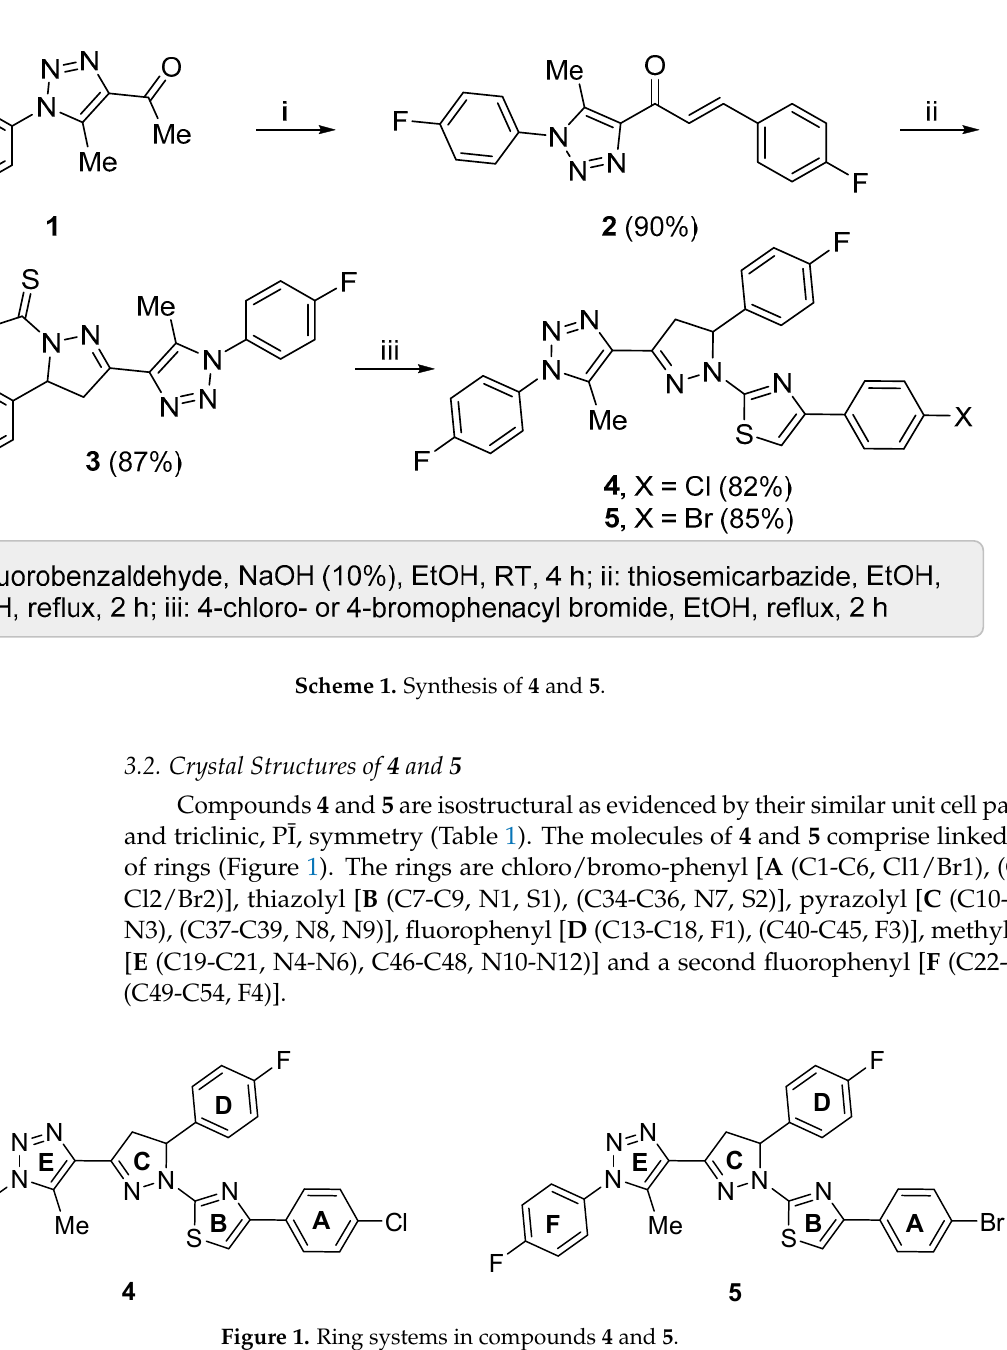
( b ) Figure 2. Ortep representation of the asymmetric unit showing 50% probability ellipsoids for ( a ): 4 and ( b ): 5 . The following discussion applies to the structures of both 4 and 5 , although only the former is used for illustration. In the crystals, the molecules are stacked parallel to the a -